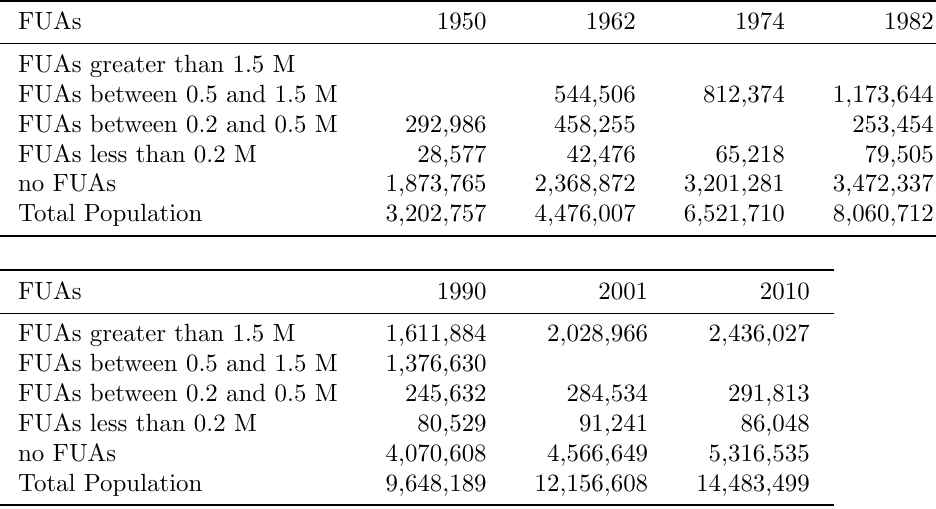
Table 1: FUAs size distribution in Ecuador (Average size)